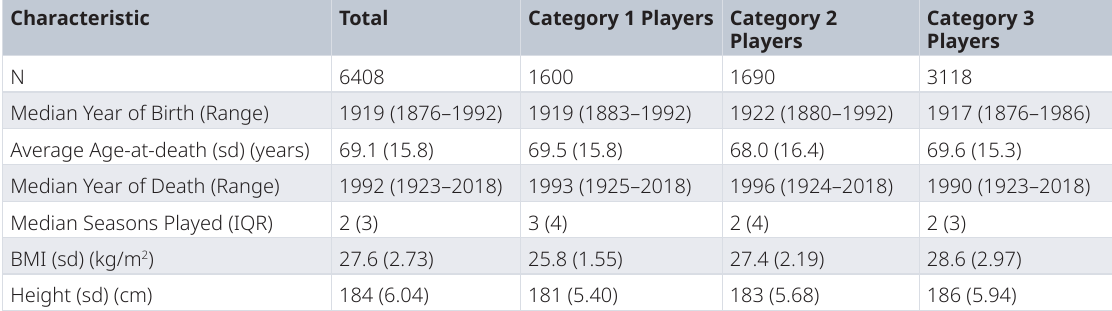
Table 1. Demographics of deceased National Football League (NFL) players